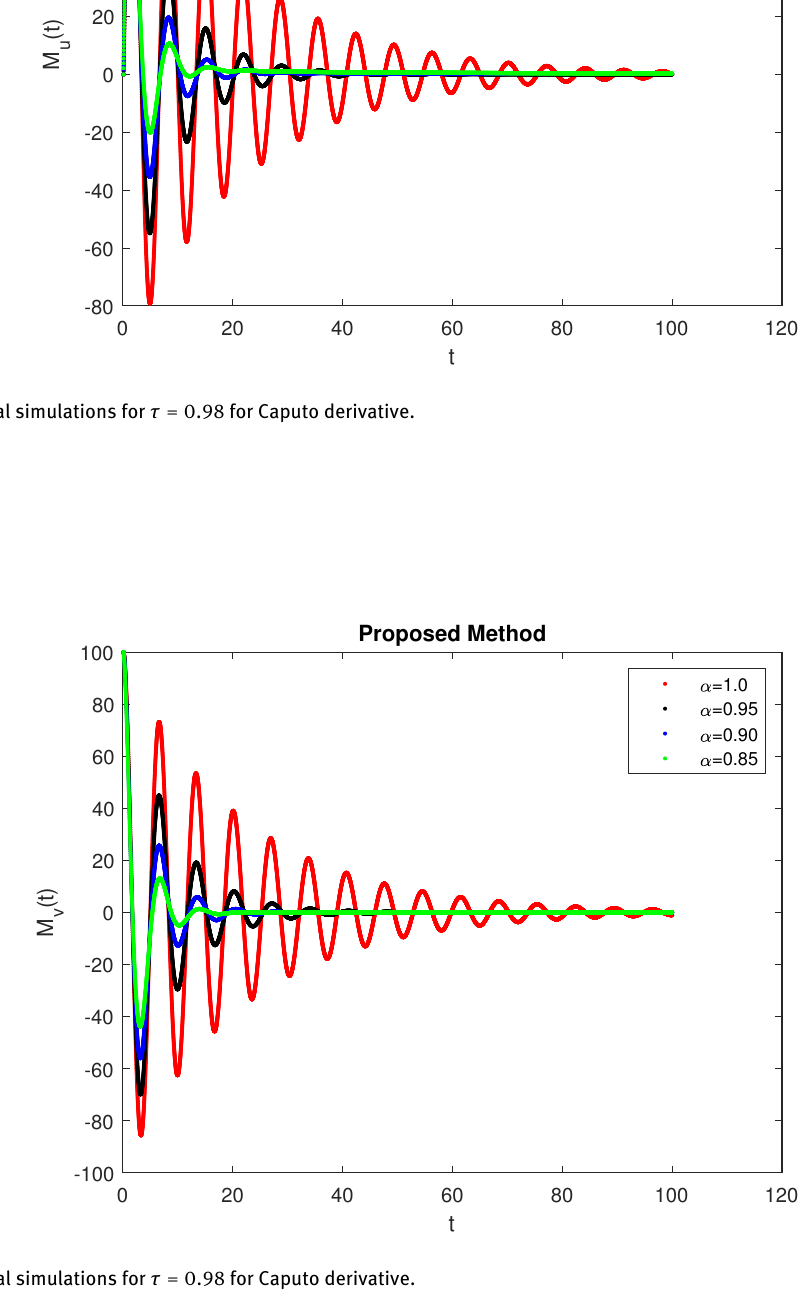
Figure 14: Numerical simulations for τ = 0.98 for Caputo